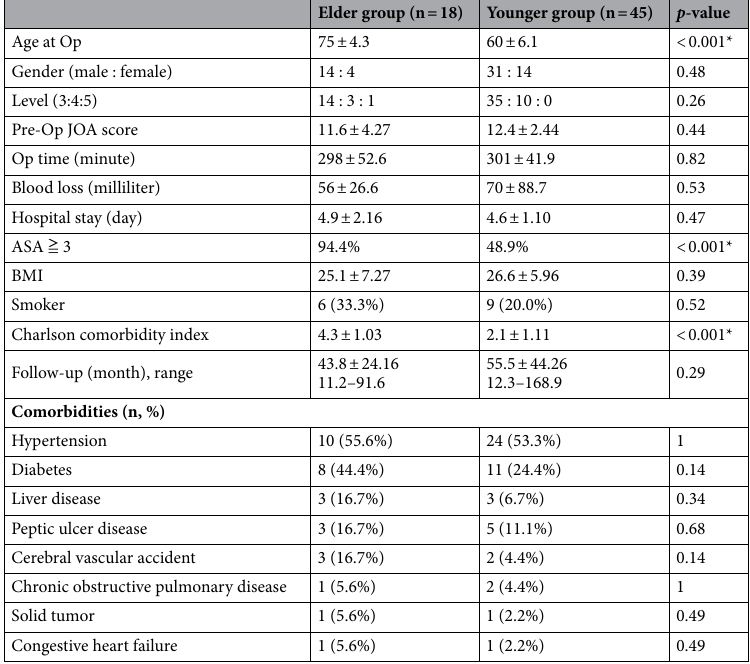
Table 1. Patients demographic. Op time skin-to-skin duration of operation, ASA American Society of Anesthesiologists Classification, JOA score Japanese Orthopaedic Association score, BMI body mass index. Elder Group: age elder then 70; Younger group: age below 70. *Statistical